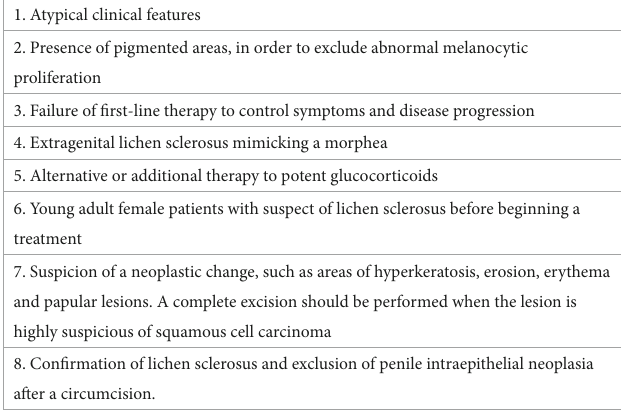
TABLE 2 Recommendations for histological examination in lichen sclerosus (124).